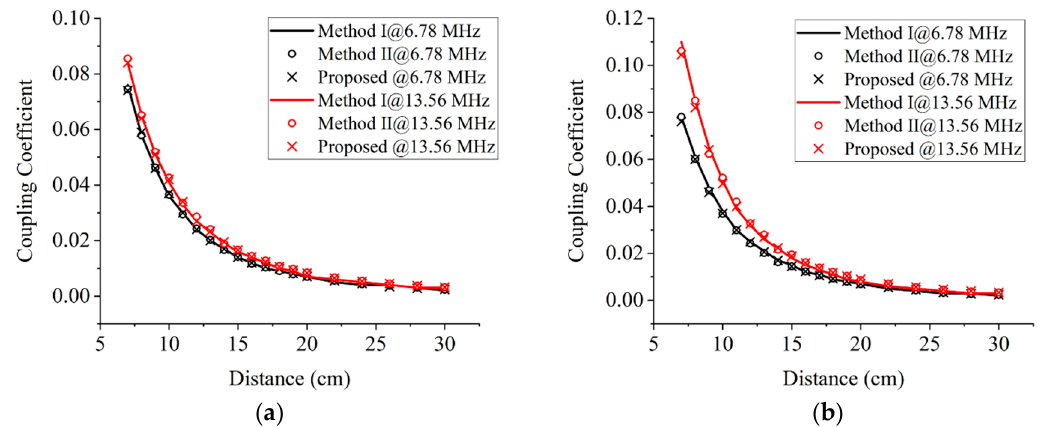
Figure 7 . Measured coupling coefficients of three coils as a function of distance using the conventional and proposed methods at 6.78 and 13.56 MHz: ( a ) Case #1 and ( b ) Case #2. Table 2. Mean and standard deviation of difference between the results of Method I and the proposed method. at 6.78 MHz at 13.56 MHz Mean St Dev. Mean St Dev.